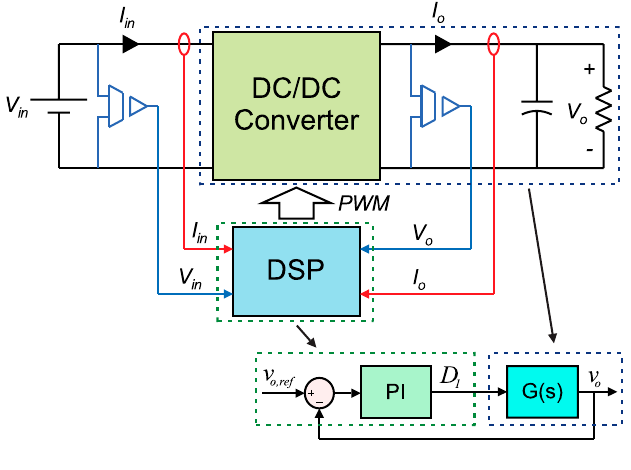
Figure 6. Control scheme.